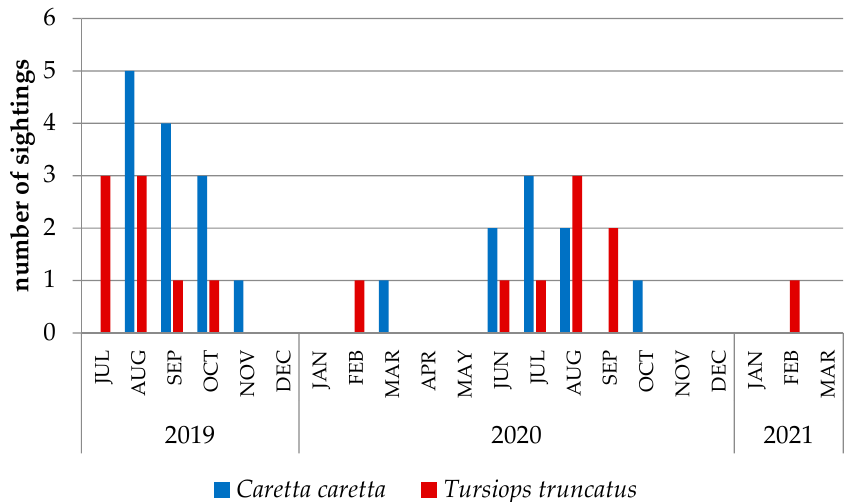
Figure 11. Number of sightings per month of marine turtles C. caretta and bottlenose dolphins T. truncatus .